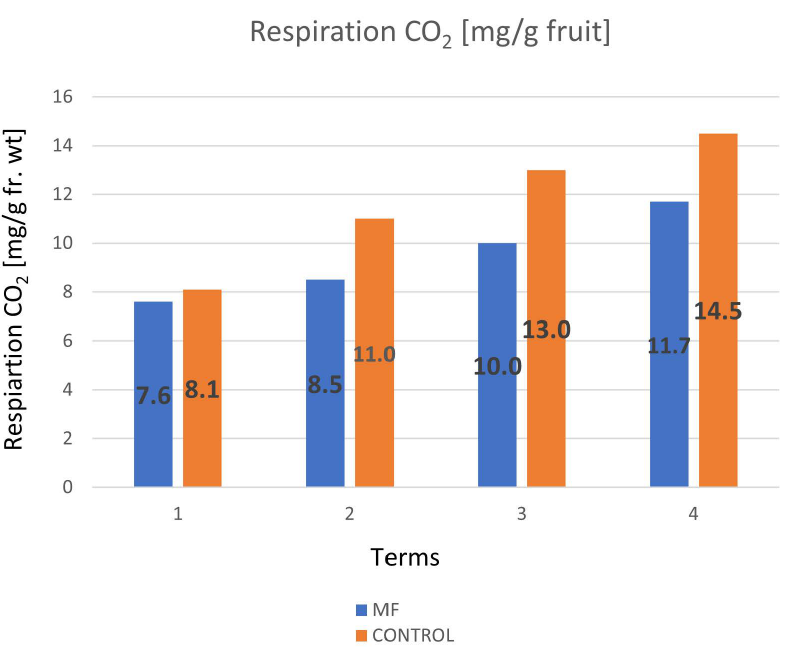
Figure 12. Effects of MF on the respiration rate of Idared apples.